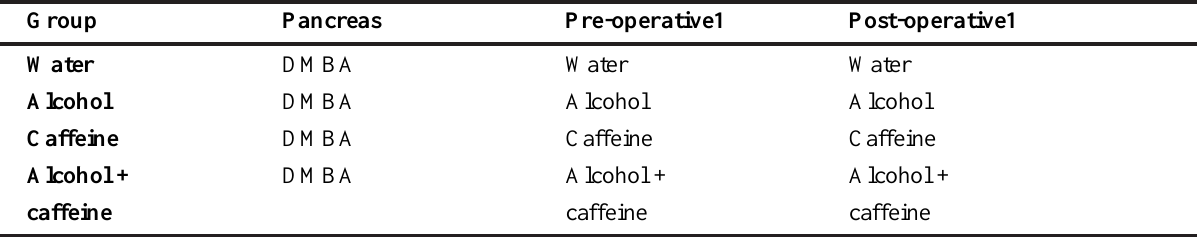
TABLE 1 - Characterization of the experimental